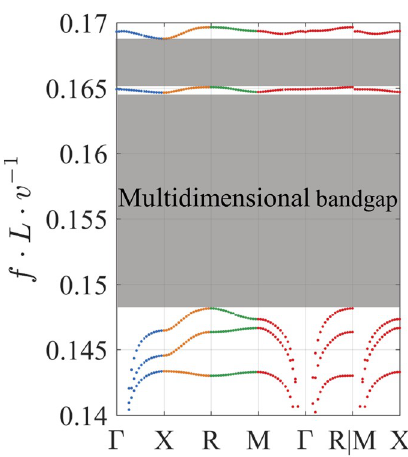
Figure 8. Multidimensional bandgaps identified from calculations of the full contour of the IBZ. The DC calculations make use of infinite periodic boundary conditions in the FE models.